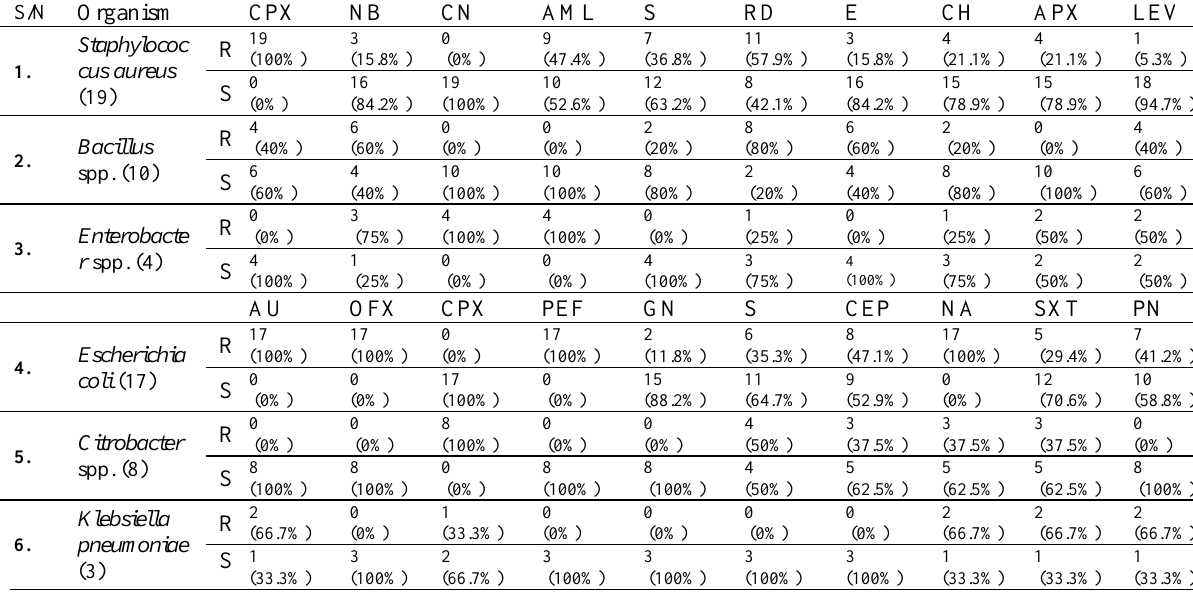
Table 1. Antibiotic resistance profile of bacterial isolates